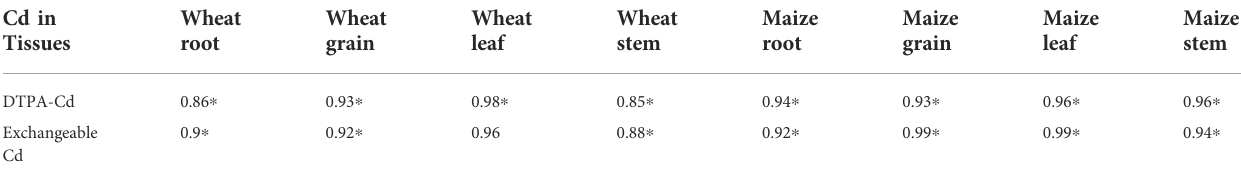
TABLE 3 Regression relationship between DTPA-extracted and exchangeable Cd in soils and Cd concentrations in wheat and maize